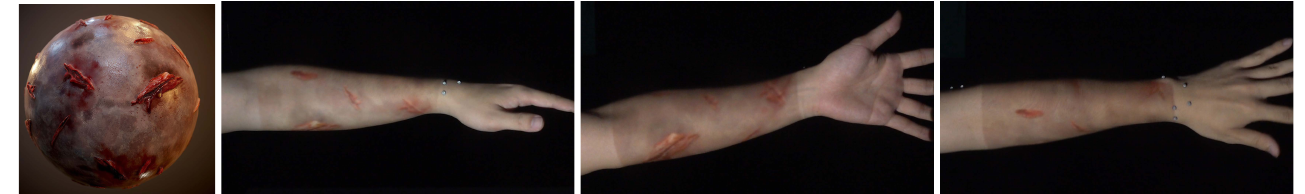
Figure 10. Wound generated with physically based rendering texture (first column), wound effect projected on the forearm (second to fourth